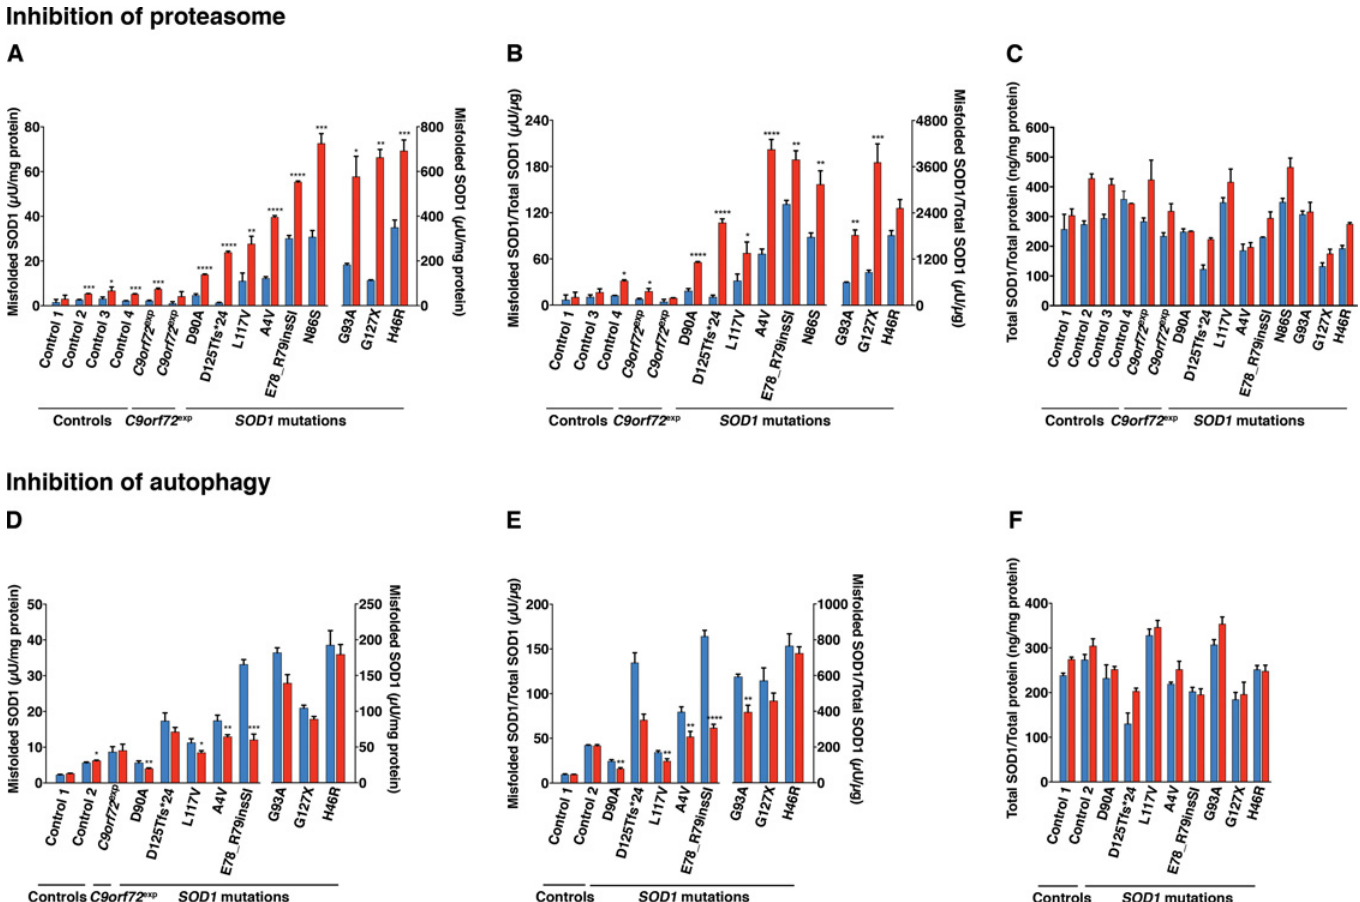
Fig 2. Effect of reduction in the activities of the proteasome and autophagy on the levels of misfolded and total SOD1 in fibroblast lines. Misfolded and total SOD1 in lysates of fibroblasts were analysed with the 24 – 39 misELISA and ELISA for total SOD1, respectively. Fibroblast cell lines were cultured in triplicate for 24 h in the absence (blue) or the presence (red) of the proteasome inhibitor bortezomib (A-C; 5 ng/ml), the autophagy inhibitor 3-MA (D-F; 10 mM). Data is expressed as the mean ± SD (n = 3), * p < 0.05, ** p < 0.01, *** p < 0.001, **** p < 0.0001 compared to respective non-treated control (Welch test and two-tailed unpaired